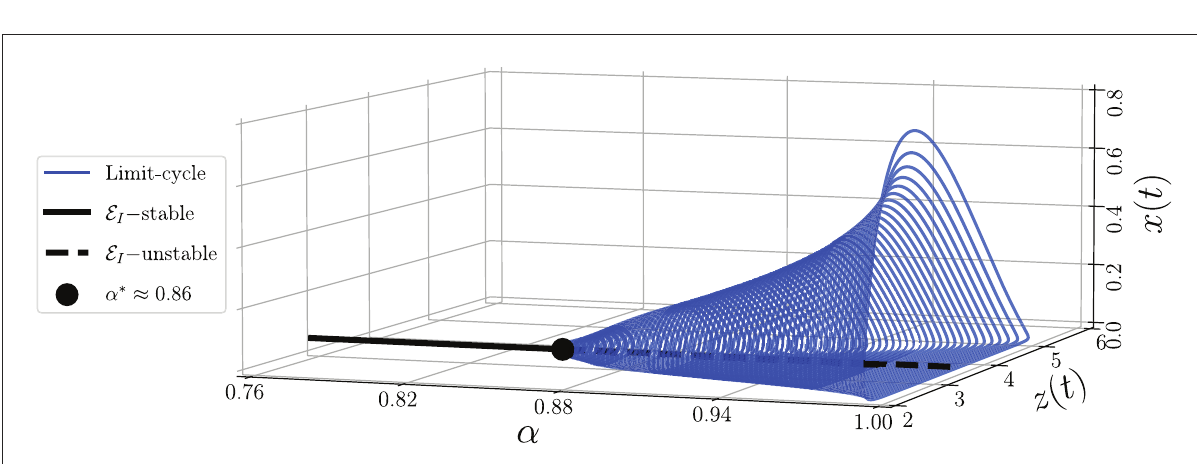
FIGURE5 Bifurcation diagram driven by the order of the derivative ( α ) of model (Equation 3) around the axial point E I using parameter values: r = 0.8, K = 5, m = 0.25, h = 0.01, c = 0.08, n = 0.2, β = 0.4, δ 1 = 0.01, δ 2 = 0.01, δ 2 = 0.01, and ω =